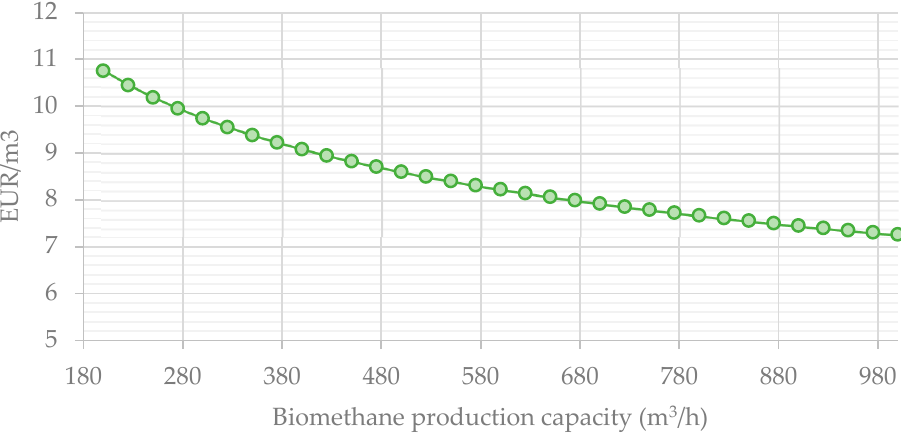
Figure 12. Biomethane production’s economy of scale estimation—based on the BIOSURF 2016 project [101]. Table 6. AD plant investment and capital cost level concerning the production scale of bio- methane.